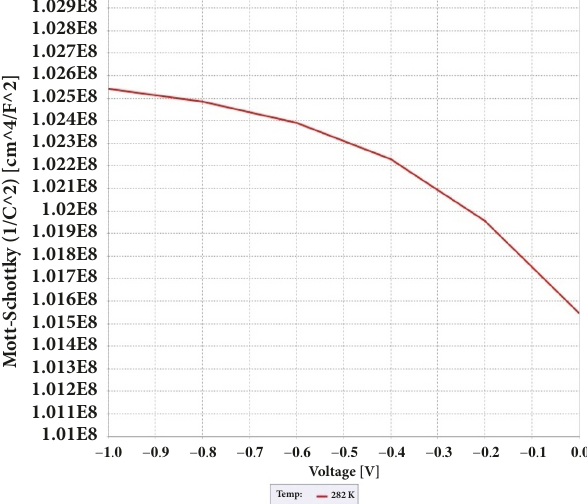
Figure 18: Mott-Schottky plot of device R at 282K.